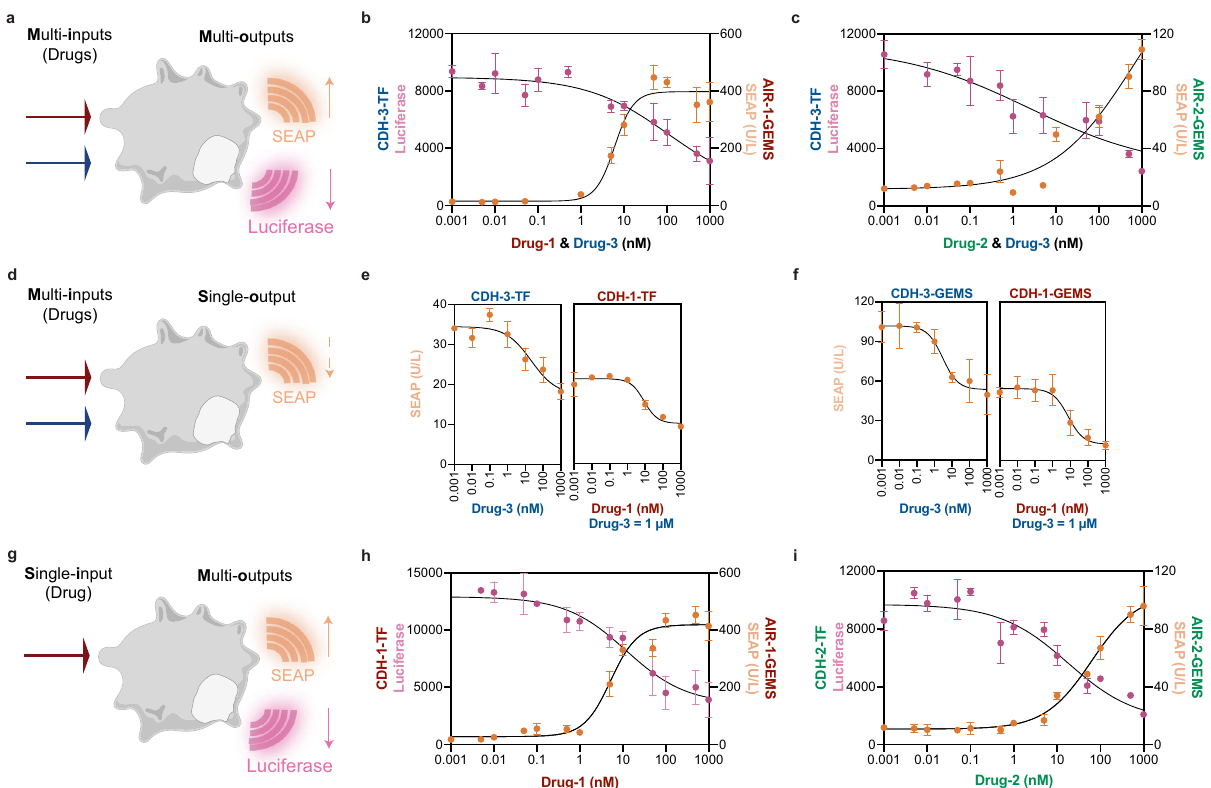
Fig. 5 Orthogonal chemical switches enable implementation of multi-input multi-output control modes in mammalian cells. a Scheme of multi-inputs multi-outputs (MIMO) designer cells where two drugs control two different outputs. b , c Cells were co-transfected with AIR-1/2-GEMS and CDH-3-TF regulate SEAP and Luciferase expression, respectively. Drug concentrations ranged from 0.001 nM to 1 µ M and different combinations were added depending on the protein components, Drug-1 + Drug-3 ( b ) and Drug-2 + Drug-3 ( c ). d Scheme of multi-inputs single-output (MISO) designer cells where two drugs control one output. e , f Quanti fi cation of SEAP activity controlled by CDH-1-TF and CDH-3-TF circuits ( e ) or CDH-1-GEMS and CDH-3-GEMS ( f ). Drug-3 concentrations ranged from 0.001 nM to 1 µ M and Drug-1 treatments were performed in the presence of 1 µ M Drug-3. g Scheme of single-input multi-outputs (SIMO) designer cells where one drug controls two outputs. h , i Quanti fi cation of SEAP and Luciferase activities under Drug-1 ( h ) or Drug-2 ( i ). AIR-1/2-GEMS coupled with SEAP expression circuits were co-transfected with CDH-1/2-TF circuits which control the Luciferase production. Respective drug concentrations ranged from 0.001 nM to 1 µ M. All values presented are mean ± s.d. of three replicates and curves were fi tted by four- parameters nonlinear regression. b , c , e , f , h , i Source data are available in the source data fi